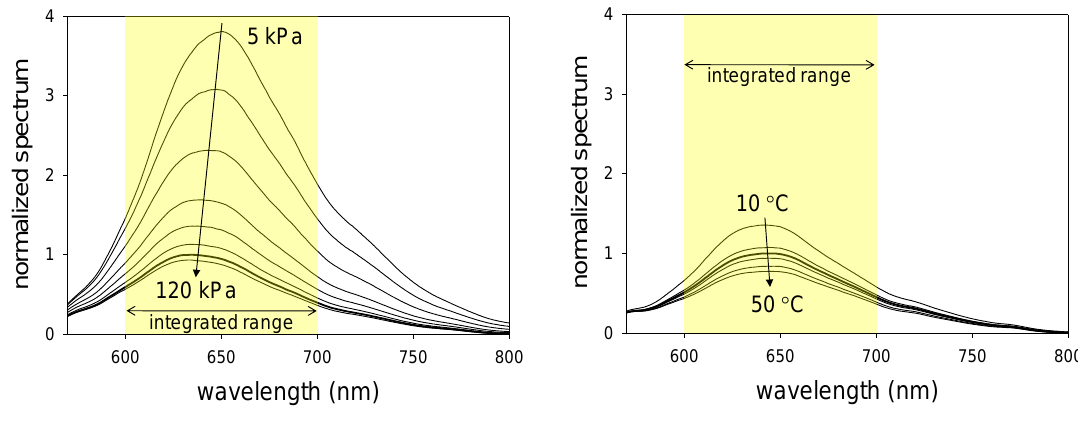
Figure 5. (a) Pressure spectra and (b) temperature spectra of AAPSP shows the spectrum at reference conditions of 100 kPa and 25 